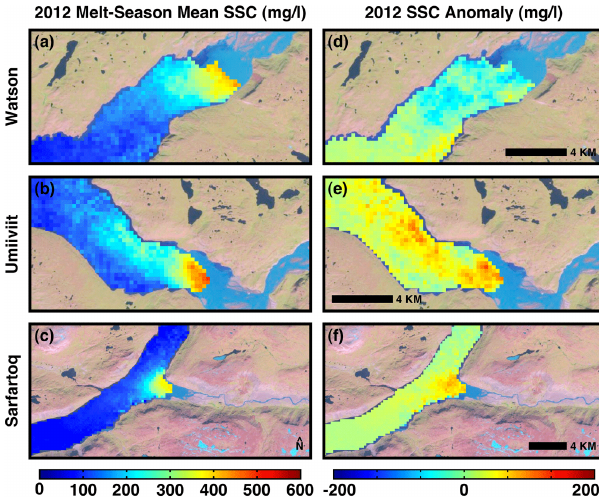
Figure 13. Maps of 2012 melt-season mean suspended sediment concentration (SSC msm ) and its anomaly from its 2000 through 2012 mean for plume regions of interest. Landsat 7 false color im- age from 7 July 2001 underlaid for